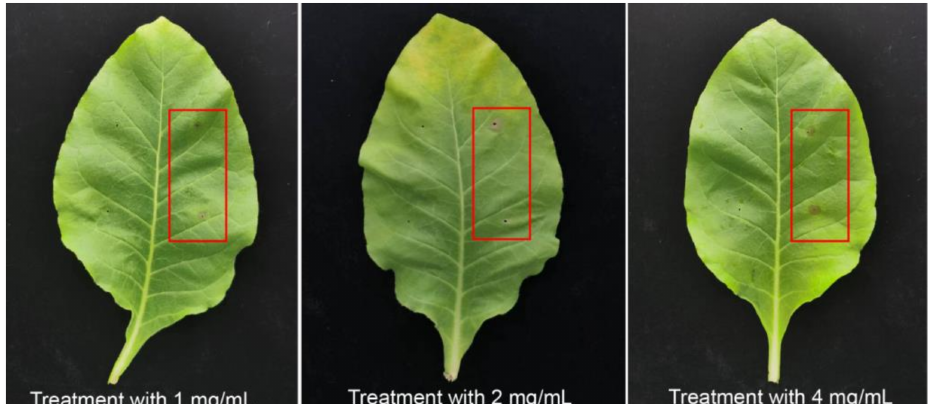
Figure 5. The symptoms of 3-MOPAA inoculation on N. tabacum (NC89) with different concentrations. Sterile water was used as control, and the red frames were the treatment groups with